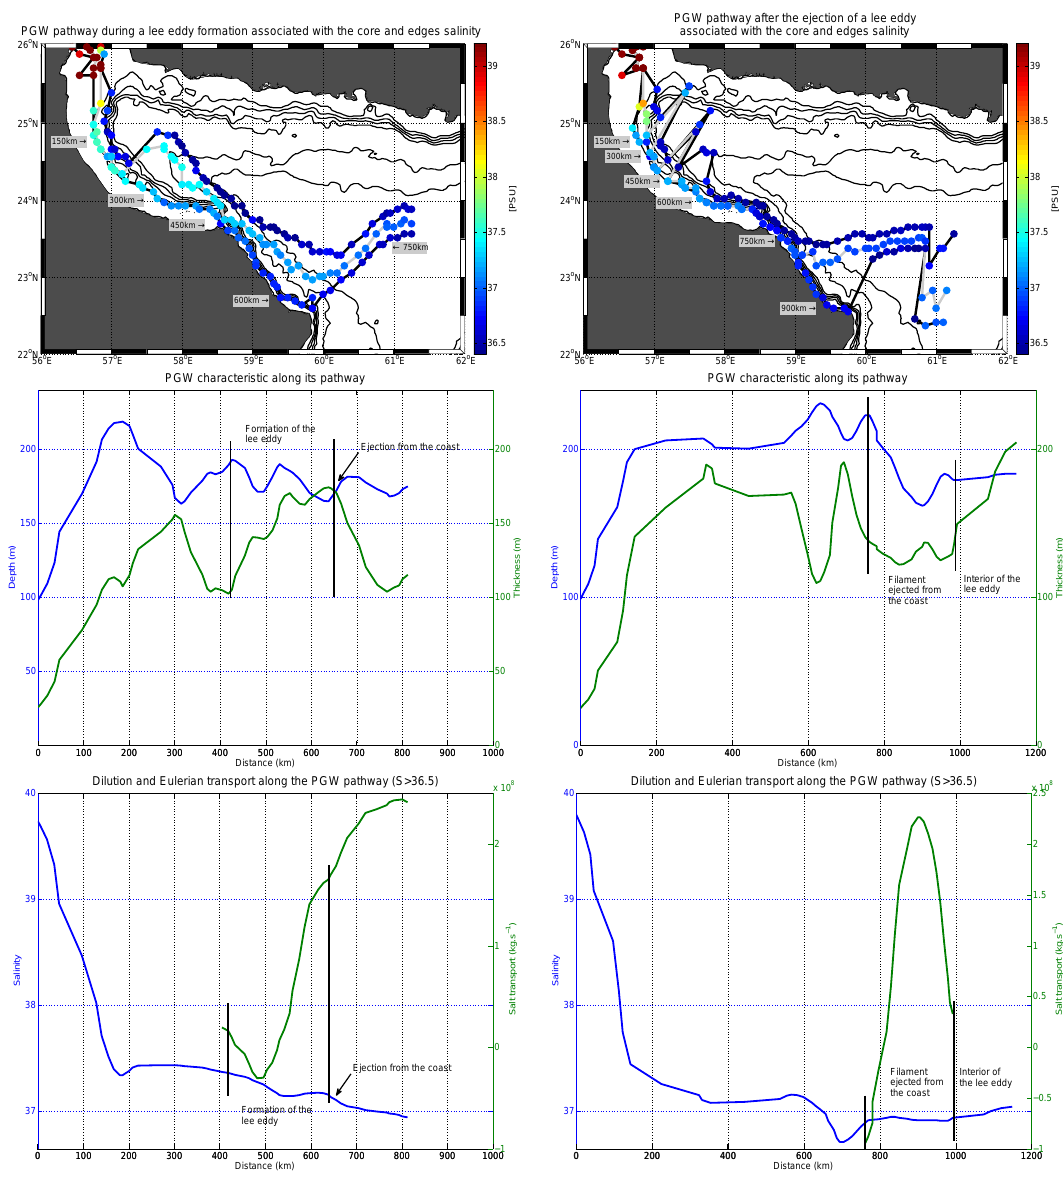
Figure 20. Evolution of the PGW characteristics during the formation of a lee eddy (on 11 November, left) and after its ejection from the coast (on 29 November, right). The first row shows the pathway of the maximal salinity of PGW and the width of the outflow. The second row displays the depth and thickness of the outflow and the third row maximal salinity and transport of salt along the downstream bathymetry.